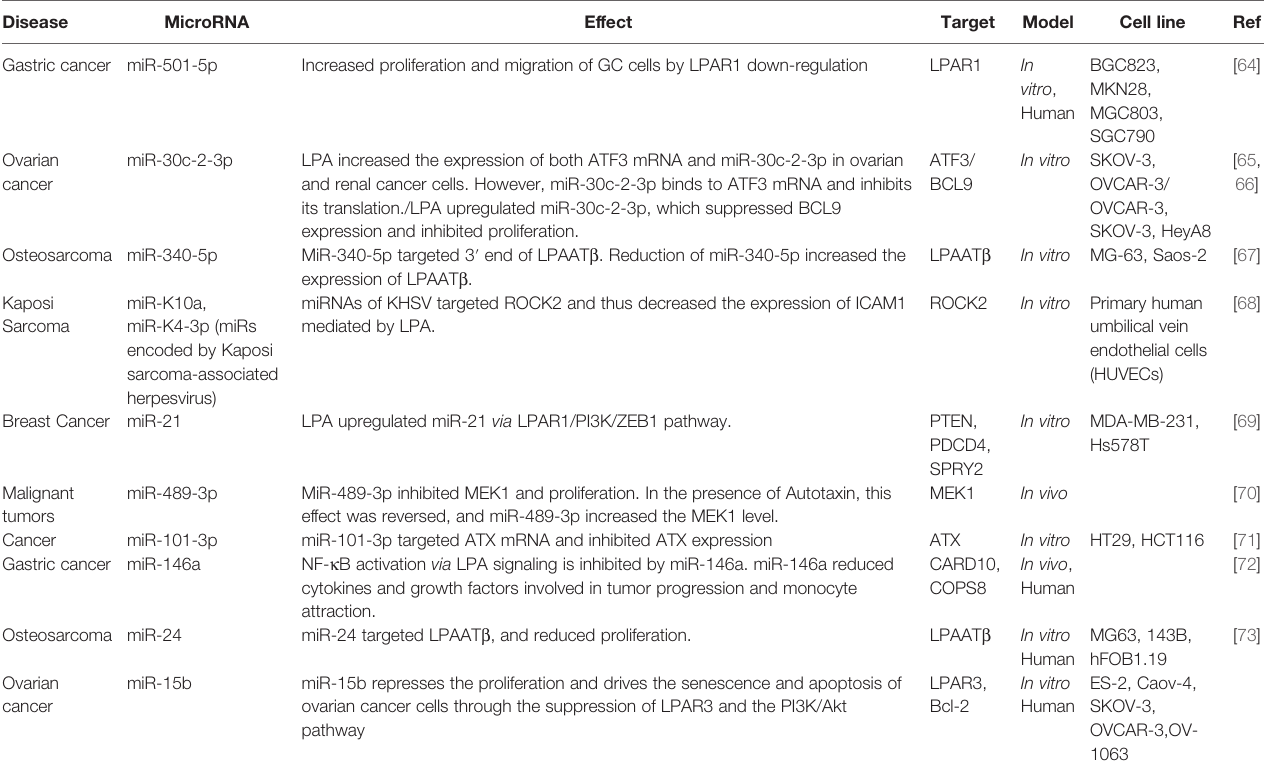
TABLE 1 | Various miRNAs have been reported to be involved with LPA and its signaling pathways in various